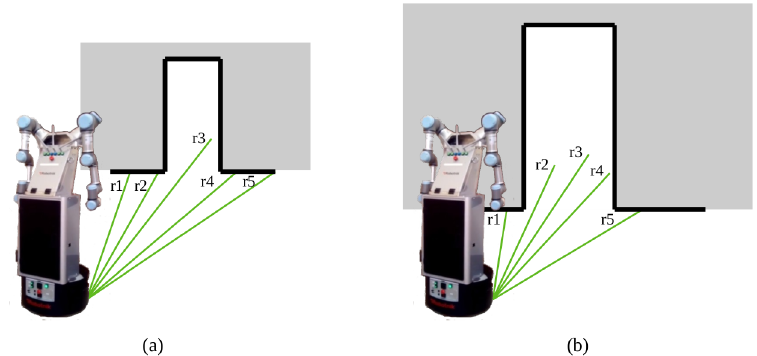
Figure 7. Door-crossing behavior where LiDAR rays, marked in green, are used for correcting the robot pose: ( a ) r 2, r 4 and r 3 are checked ( b ) r 1, r 5 and r 3 are